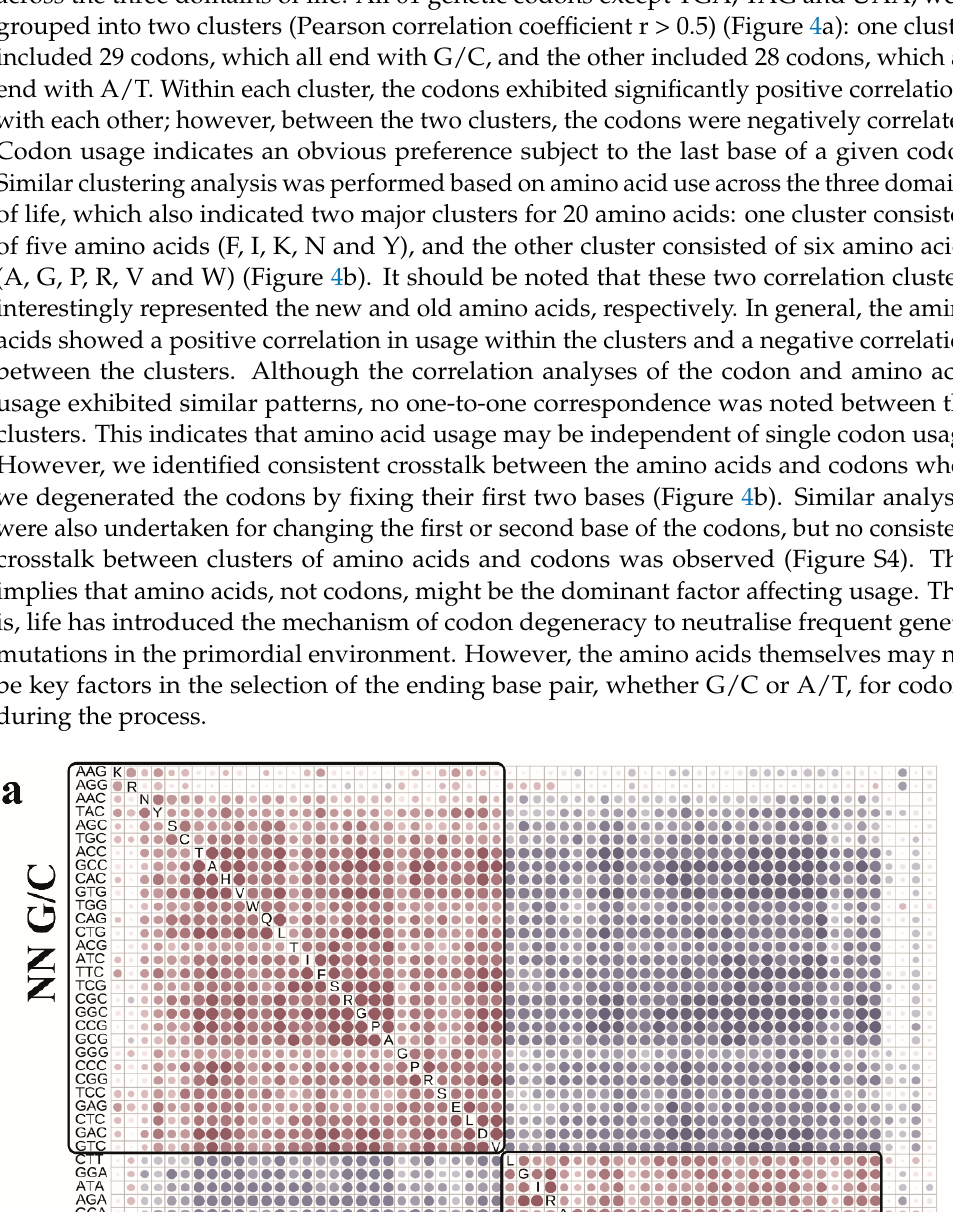
Figure 4. Correlation analysis of amino acids/genetic codons. ( a ) Correlation analysis of codon us- age (excluding stop codons) in all species. Note: N represents any base. ( b ) Correlation analysis of amino acid usage (bottom left) and codon usage with the same first two bases (top right) in all